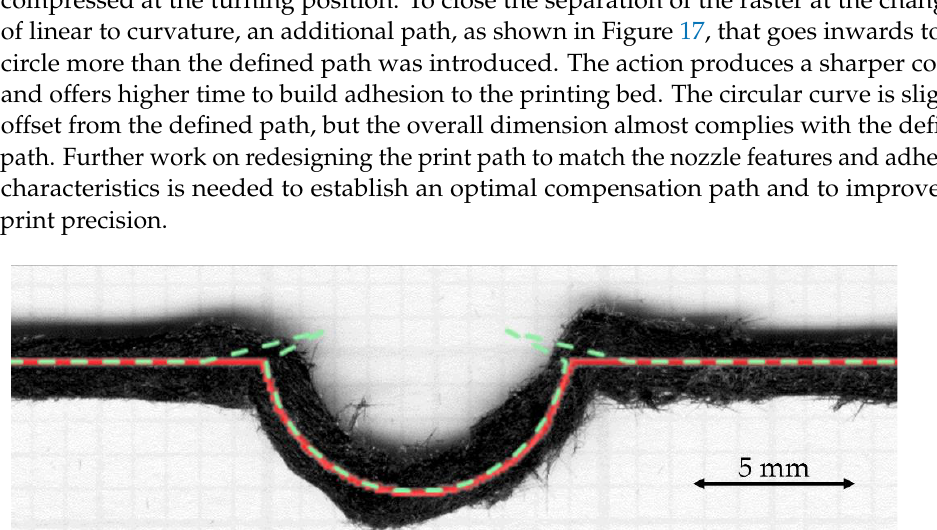
Figure 16. ( a ) Printing path of large square spiral with 3-mm turning radius at the corners; ( b ) top surface of the radius printed part with a zoom-in of a corner.